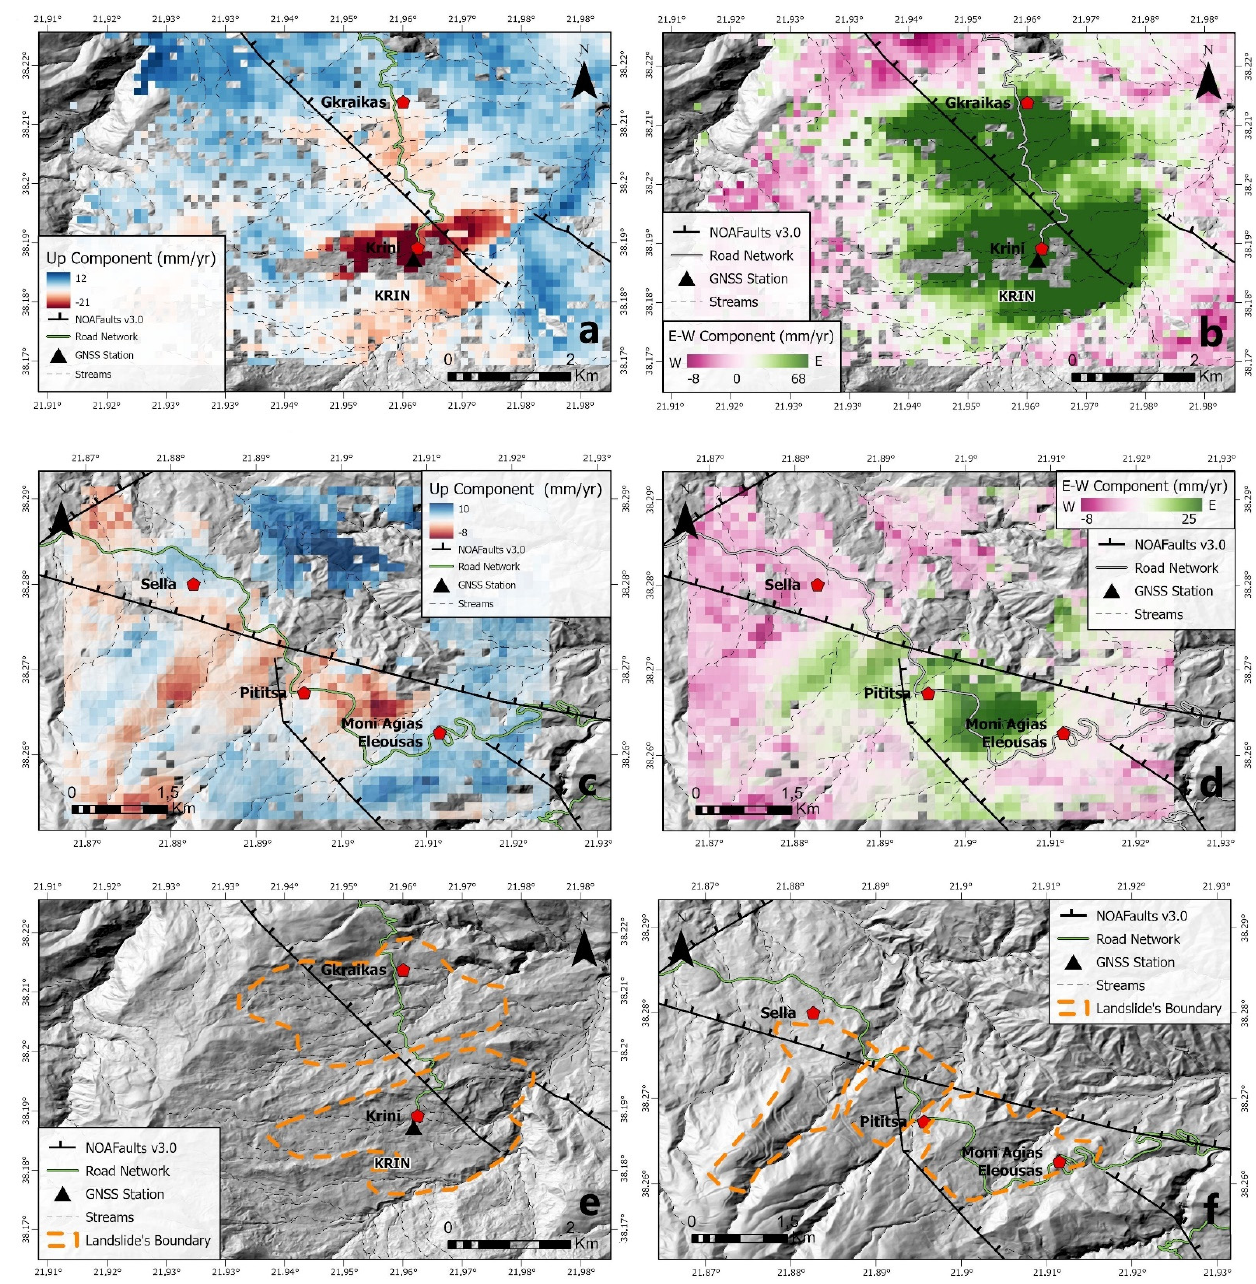
Figure 6. Displacement-rate maps in mm/yr: Up ( a , c ) and E-W ( b , d ), component after the decompo- sition of InSAR data for the broader areas of Krini and Pititsa villages, respectively; ( e ), showing the landslides’ outlines for Krini and Graikas landslides; and ( f ), showing the landslides’ outlines for the monastery Agia Eleoussa and the villages of Pititsa and Sella.